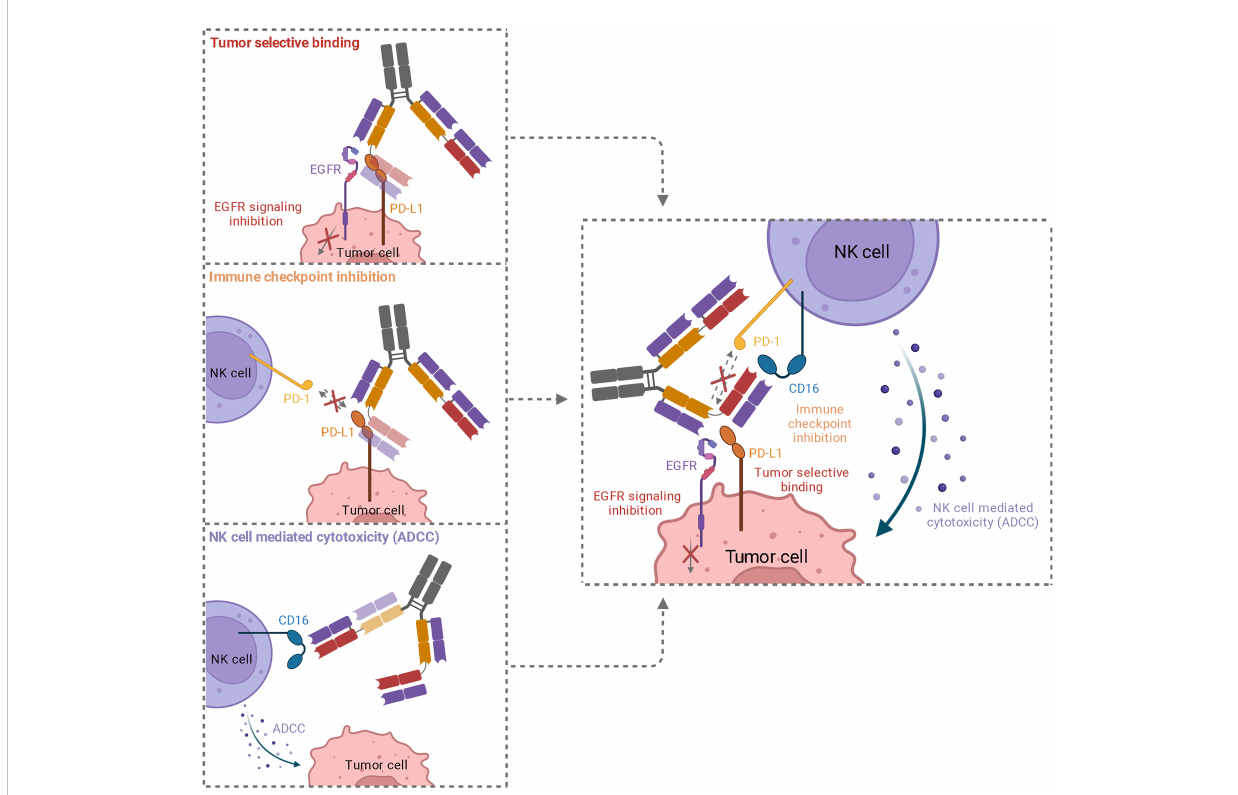
FIGURE 6 Schematic representation of the three functionalities of trispeci fi c 2 + 2 antibody variant HC16-HCP. While simultaneous binding of EGFR and PD-L1 mediated an elevated tumor speci fi city, EGFR downstream signaling is inhibited and PD-L1 is blocked, inhibiting interaction with PD-1 on NK cells. The recruitment of cytotoxic NK cells via CD16a engagement leads to an effective